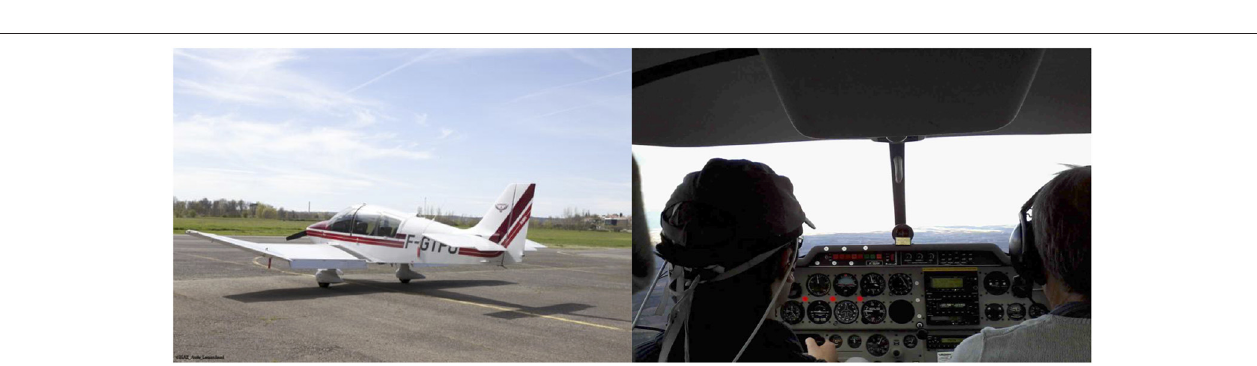
FIGURE 8 | (Left) ISAE Supaero DR400 plane used for the experiment. (Right) The pilot subject with the mini-fNIRS headband (on the left) and the safety pilot (on the right).